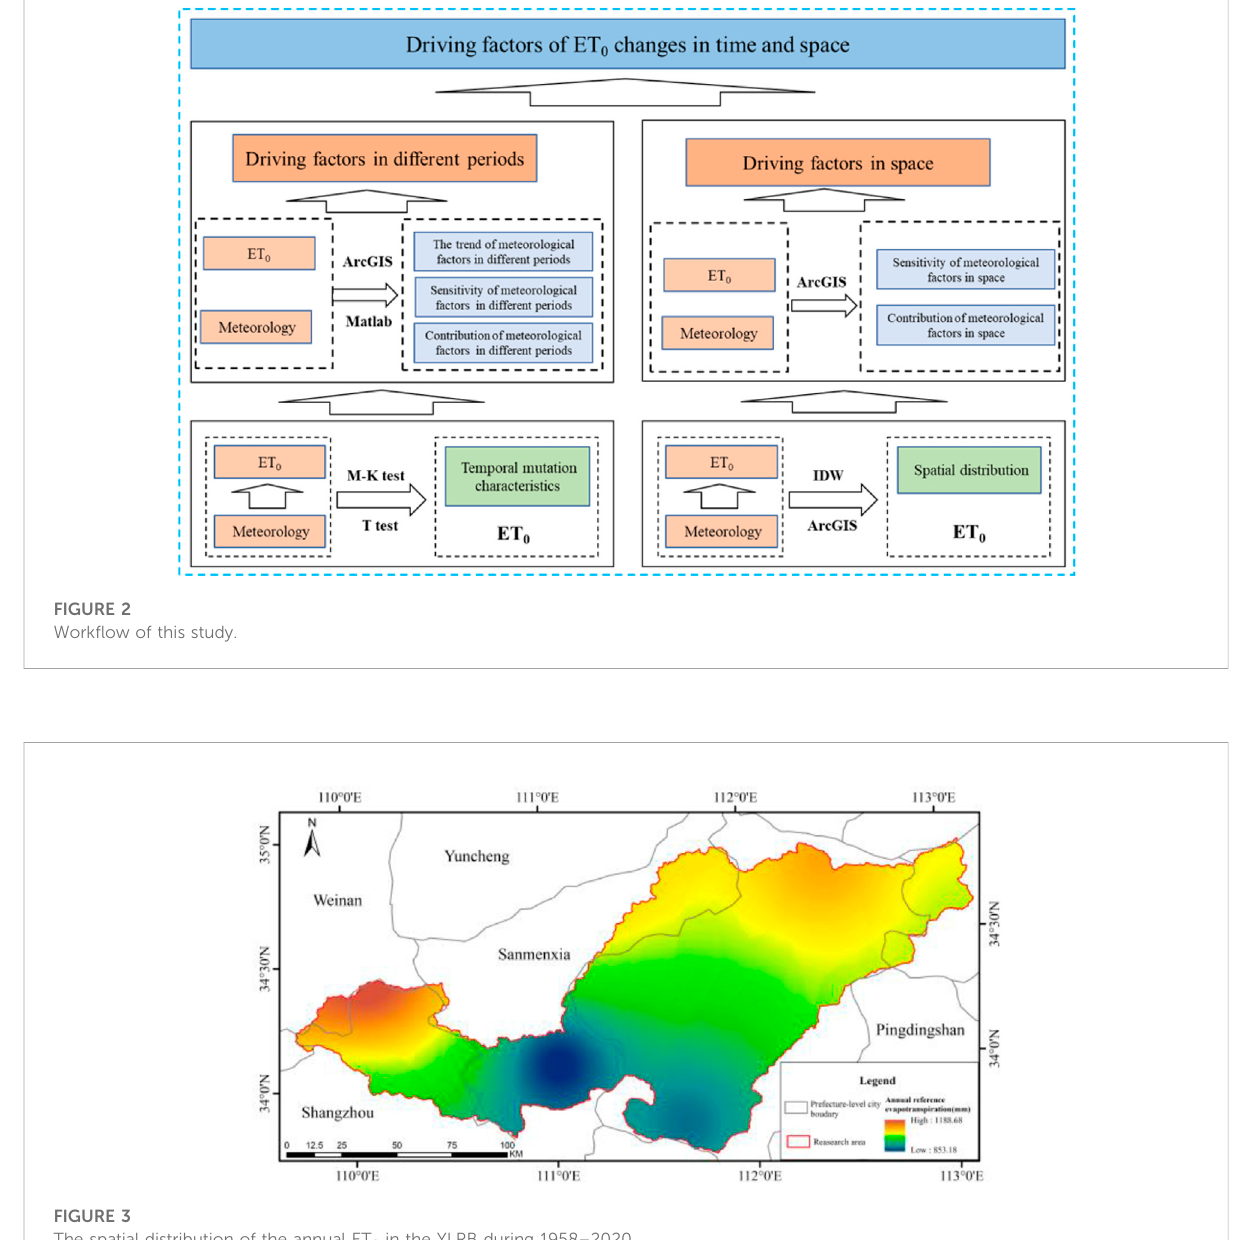
The spatial distribution of the annual ET 0 in the YLRB during 1958 – 2020.